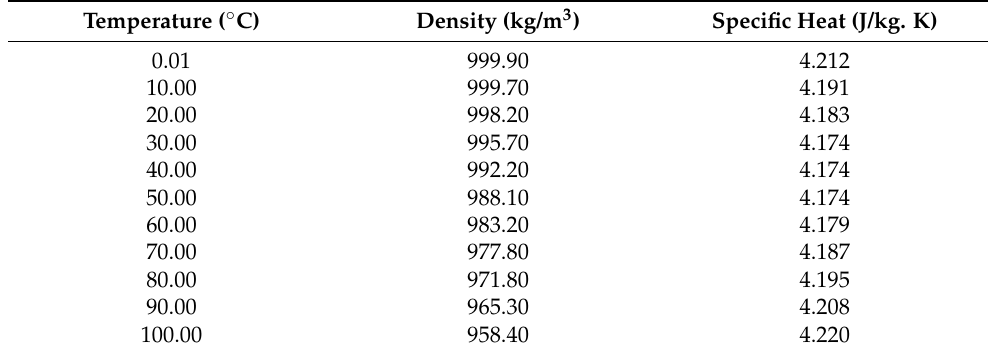
Table 2. The density and specific heat of water as a function of